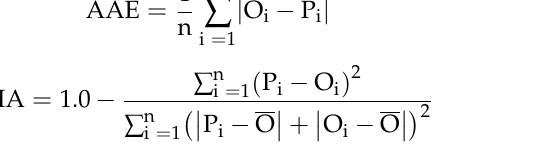
Table 4. Average values of crop coefficients (-) and precipitation (mm) for different crop growth stages.